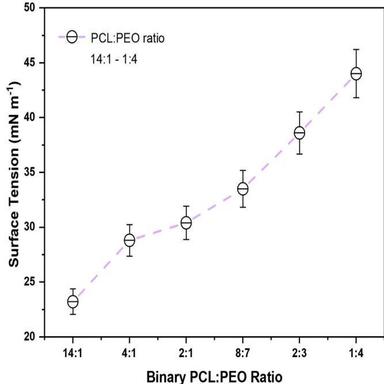
Relationship between surface tension and increase in PEO ratio of PCL: PEO binary polymer systems.